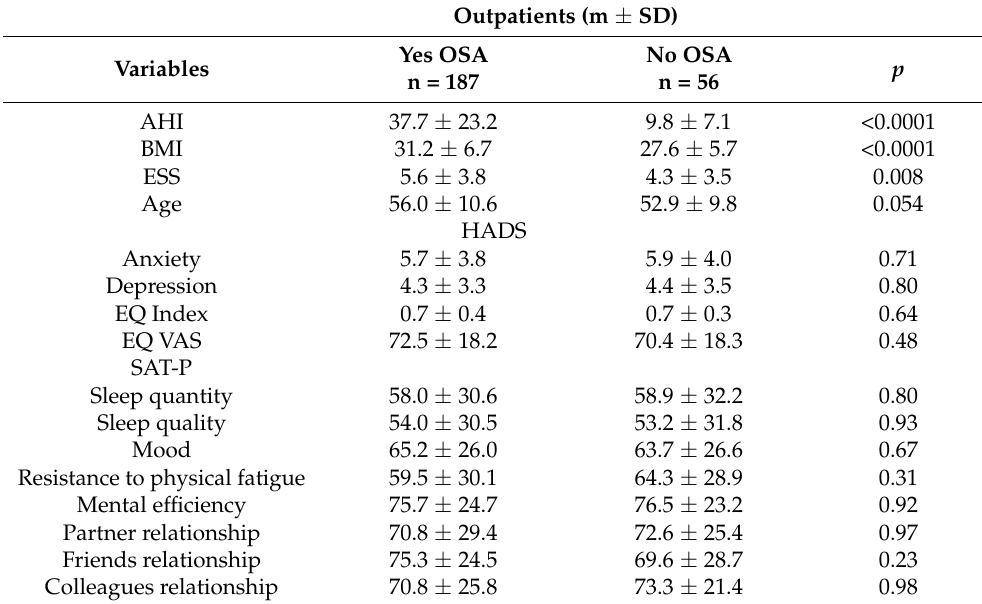
Table 1. Comparison of clinical, psychological, and HRQoL data of outpatients undergoing polysomnography